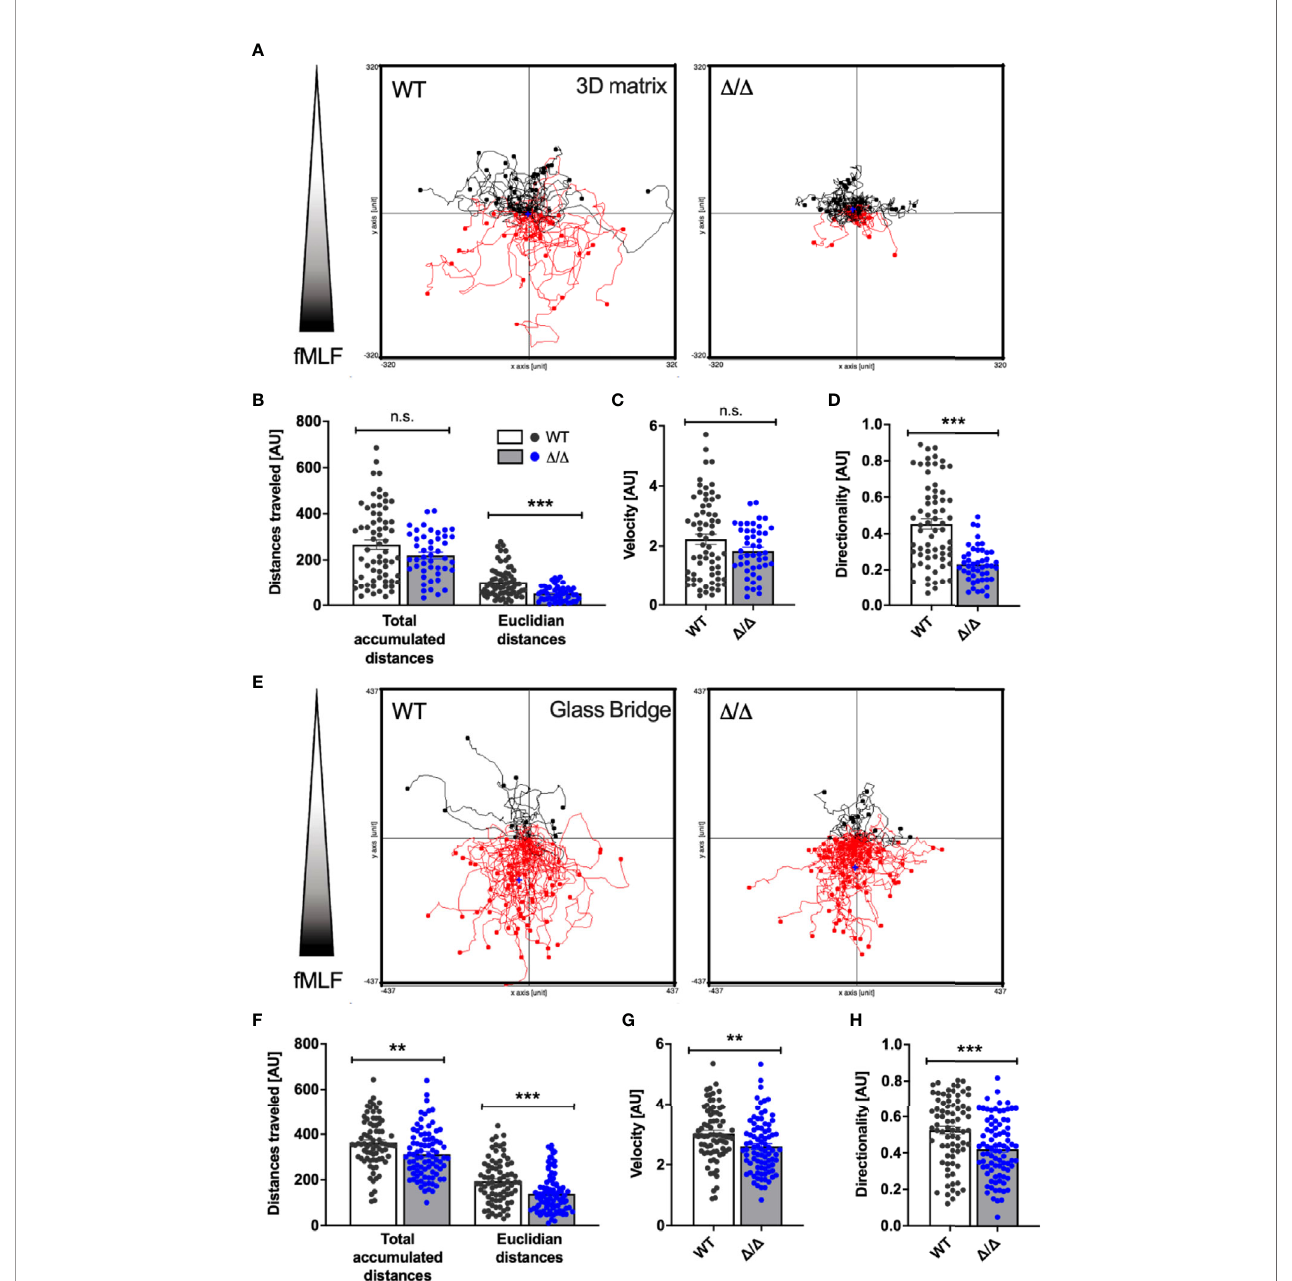
FIGURE 3 | SHIP2 activity is required for chemotactic directionality. Bone marrow-derived wild-type (WT) and Ship2 D / D ( D / D ) neutrophils were allowed to chemotax towards 300nM fMLF either embedded in a collagen-matrix in Ibidi chemotaxis m -slides (A – D) or in Dunn chemotaxis chambers (E – H) . The orientation of the gradient is indicated to the left of spider plots shown in (A) and (E) Cell migration was recorded by time-lapse imaging, with pooled tracks of individual neutrophils recorded with cells from three separate preparations were plotted as spider plots (A, E) and analyzed (B – D, F – H) using the Ibidi Chemotaxis tool plug-in into Image J. Accumulated and Euclidean distances (B, F) , Velocity (C, G) and Directionality (D, H) are plotted. p values were determined using the Mann-Whitney test. ** p < 0.01; *** p < 0.001; n.s., not signi fi